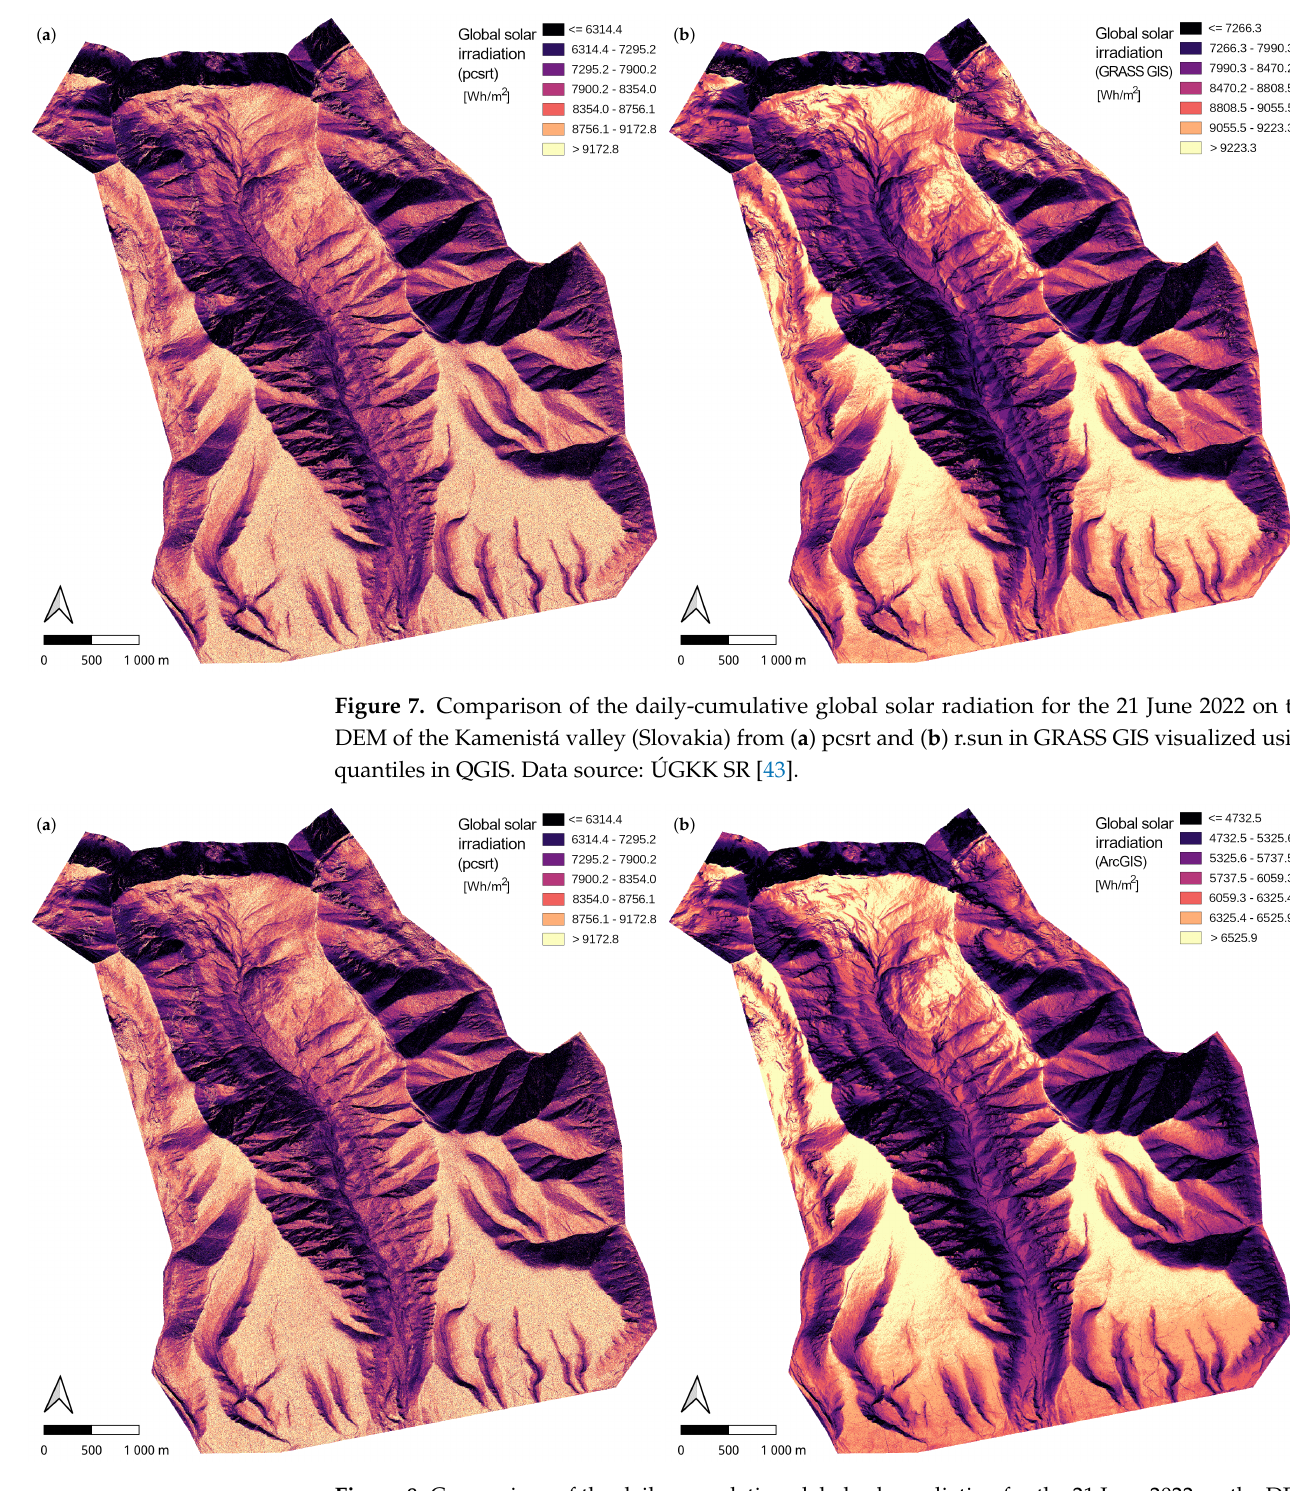
Figure 8. Comparison of the daily-cumulative global solar radiation for the 21 June 2022 on the DEM of the Kamenistá valley (Slovakia) from ( a ) pcsrt and ( b ) Area Solar Radiation in ArcGIS visualized using quantiles in QGIS. Data source: ÚGKK SR